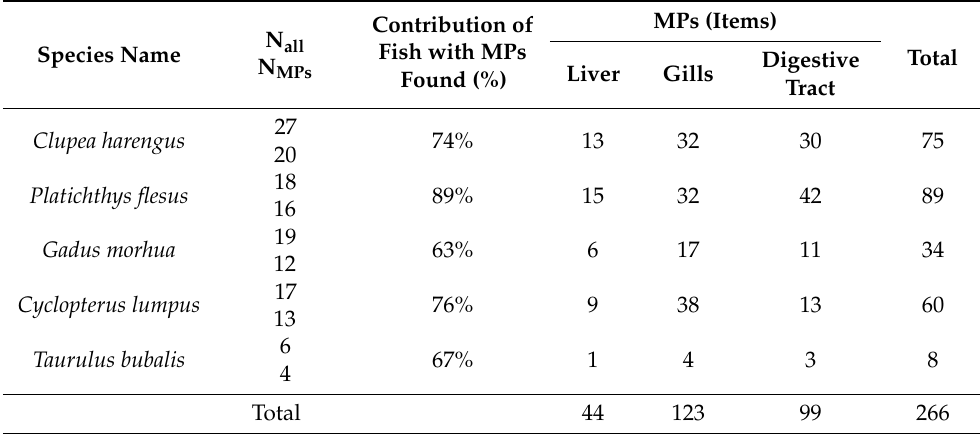
Table 2. Percentage contribution of fish with MPs identified and the distribution of plastic items according to the type of fish